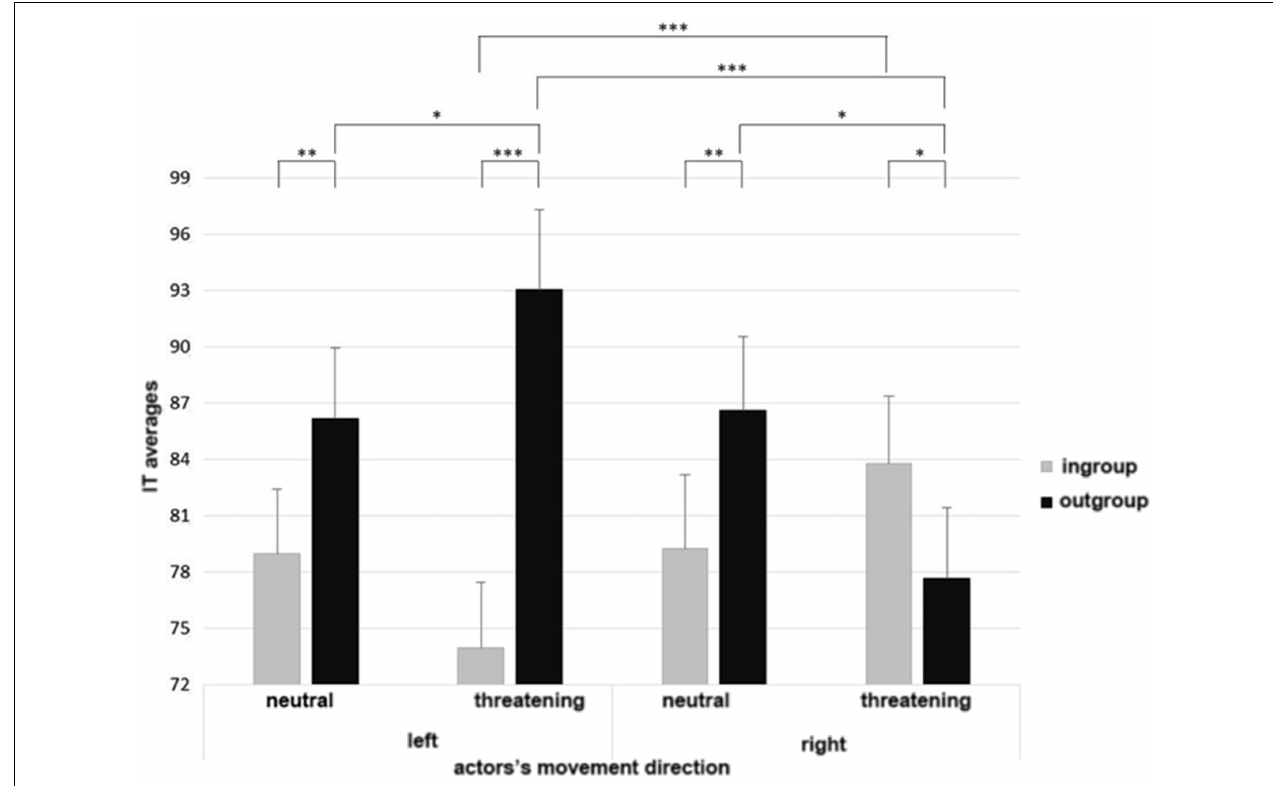
FIGURE 2 | Three-way interactions between membership, actor’s movement direction, and object valence [Initial Times (IT)]. Asterisks highlight significantly different means comparisons ( ∗ p < 0.05, ∗∗ p < 0.01, ∗∗∗ p < 0.001). Error bars represent standard errors.